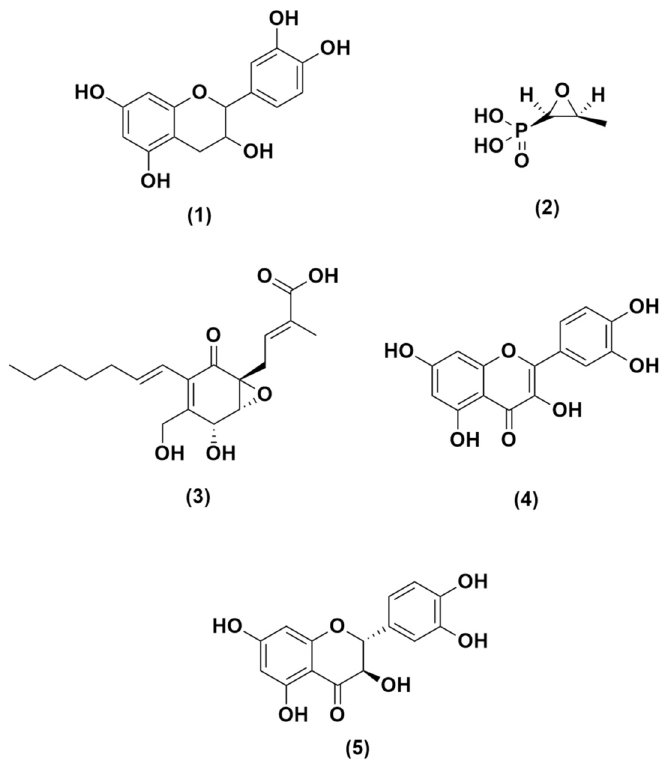
Figure 5. Structure of compounds of catechin ( 1 ) from Gambir ( Uncaria gambir Roxb.); positive control: fosfomycin ( 2 ), ambuic acid ( 3 ), quercetin ( 4 ) and taxifolin ( 5